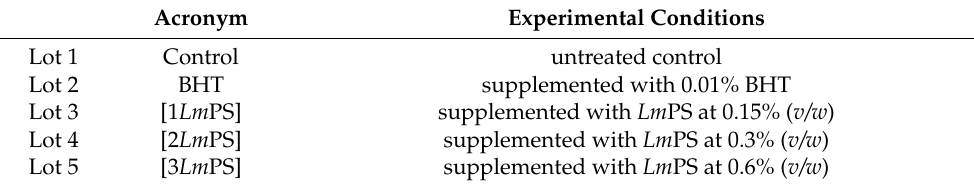
Table 1. Experimental conditions for sample preparation. Acronym Experimental